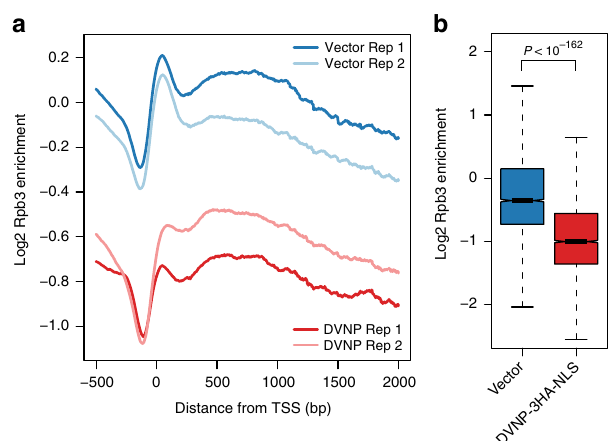
Fig. 3 DVNP expression results in transcriptional impairment in S. cerevisiae . a Spike-in normalized average gene plot showing the enrichment of two biological replicates of Rpb3 ChIPs from DVNP-3HA-NLS-expressing and control cells. b Differences in Rpb3 following DVNP expression. Values represent the mean Rpb3 occupancy calculated over gene bodies after averaging biological replicates ( n = 4793). Outliers are shown in Supplementary Fig. 3f. The P -value was calculated using a two sided Welch ’ s t -test. Box plot notches represent an estimate of the 95% con fi dence interval of the